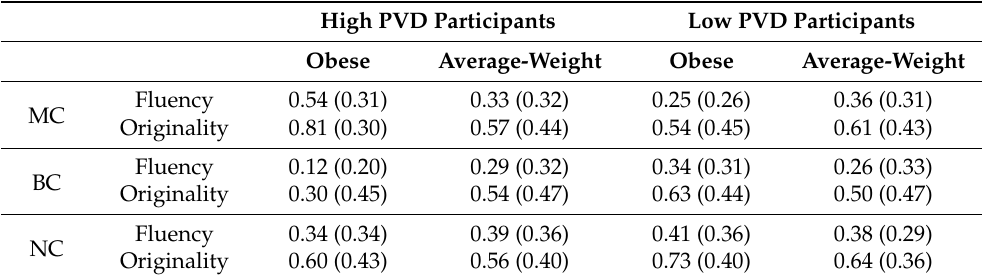
Table 3. Means and standard deviations of malevolent, benevolent, and neutral creativity in Study